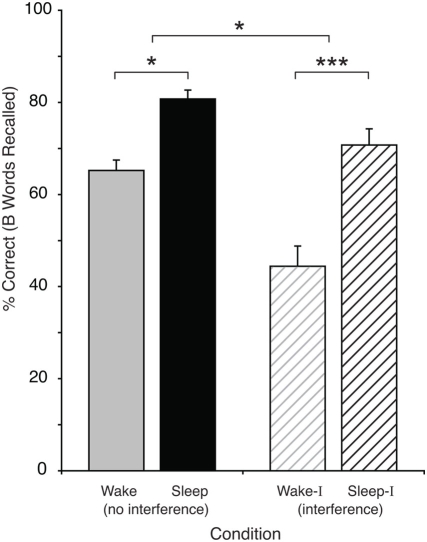
Results.Percent correct recall for B words from the original A–B pair following 12-hour retention interval, with no interference and with interference (A–C) prior to testing. Bar indicates one standard error of the mean. * = p<0.05; *** = p<0.001.